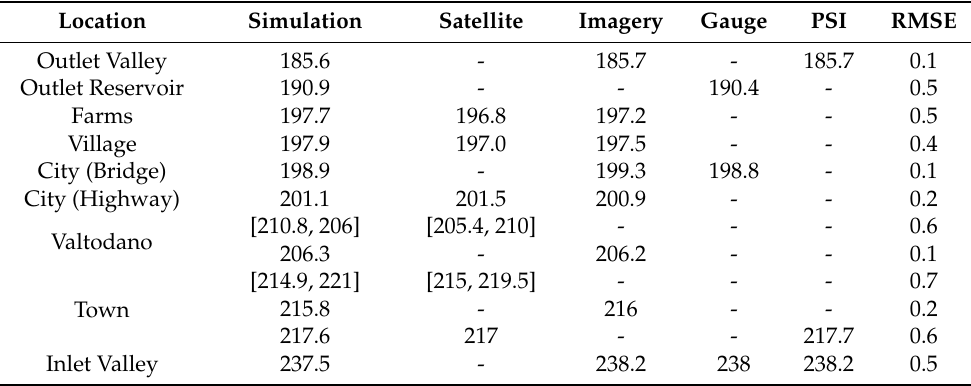
Table 3. Mean water level and RMSE in the numerical flood simulation using selected spot locations. The data source used to evaluate RMSE correspond with the following order of confidence: gauge station, in situ imagery, remote sensing data and PSI. All data are in